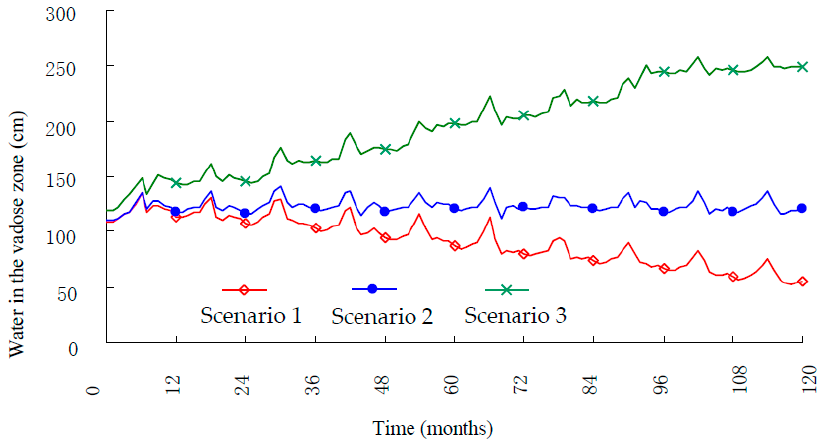
Figure 8. Monthly water storage in the unsaturated zone.